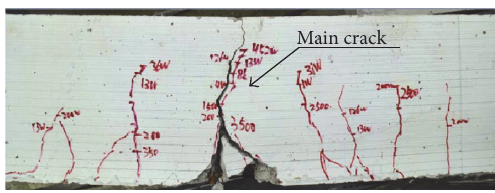
Figure 12: Morphology and distribution of cracks